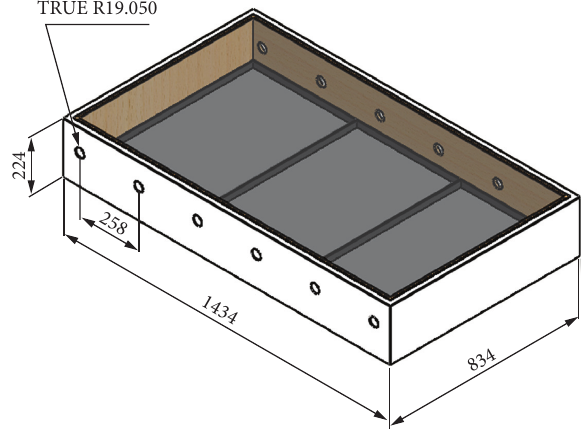
Figure 3: Solar dryer design for drying foods and